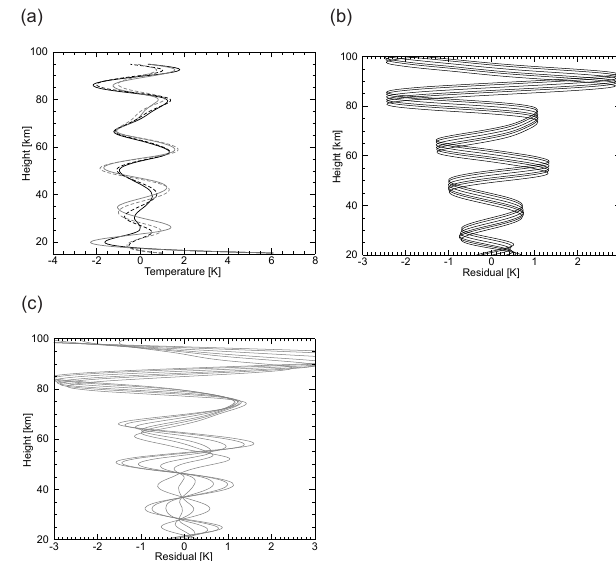
Figure 9. (a) Original CIRA temperature profile (which was de- trended between ca. 14 and 110km as the SABER data); (b) – (d) are residuals for a sampling point distance of 2.5, 5 and 10km between 20 and 100km height (grey: non-repeating spline, black: repeating spline).